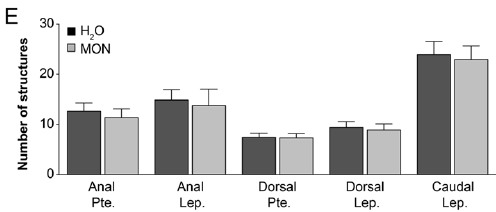
Figure 2. Parameters collected at 20 dpf, after exposure to 450 µg L −1 of MON from three dpf in triplicates of 30 larvae. ( A ) Fish survival monitored throughout the treatment; ( B ) Averaged number of centra by condition; ( C ) Averaged incidence of deformities recorded by condition; ( D ) Averaged standard length by condition; ( E ) Counting of Pte (pterygiophores) and Lep (lepidotrichia) from anal, dorsal and caudal fins. Data presented as average ± SD of average.